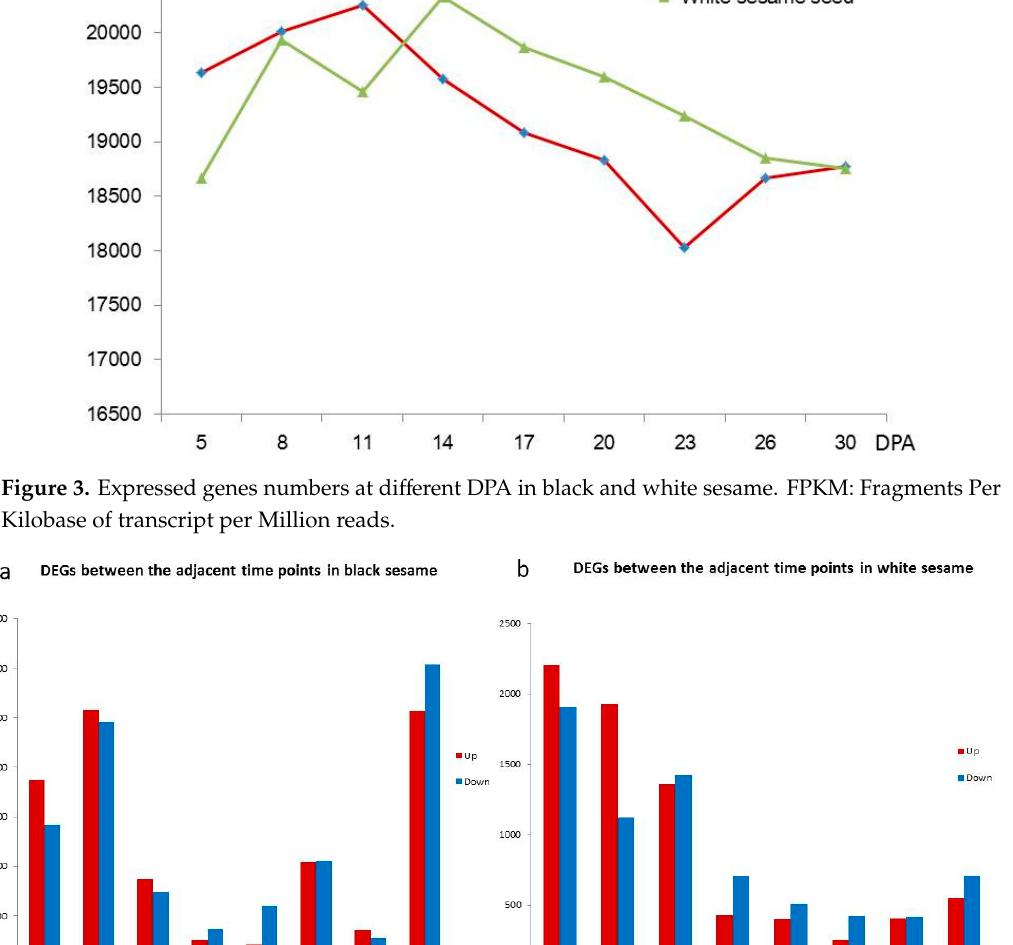
Figure 3. Expressed genes numbers at different DPA in black and white sesame. FPKM: Fragments Per Kilobase of transcript per Million reads.